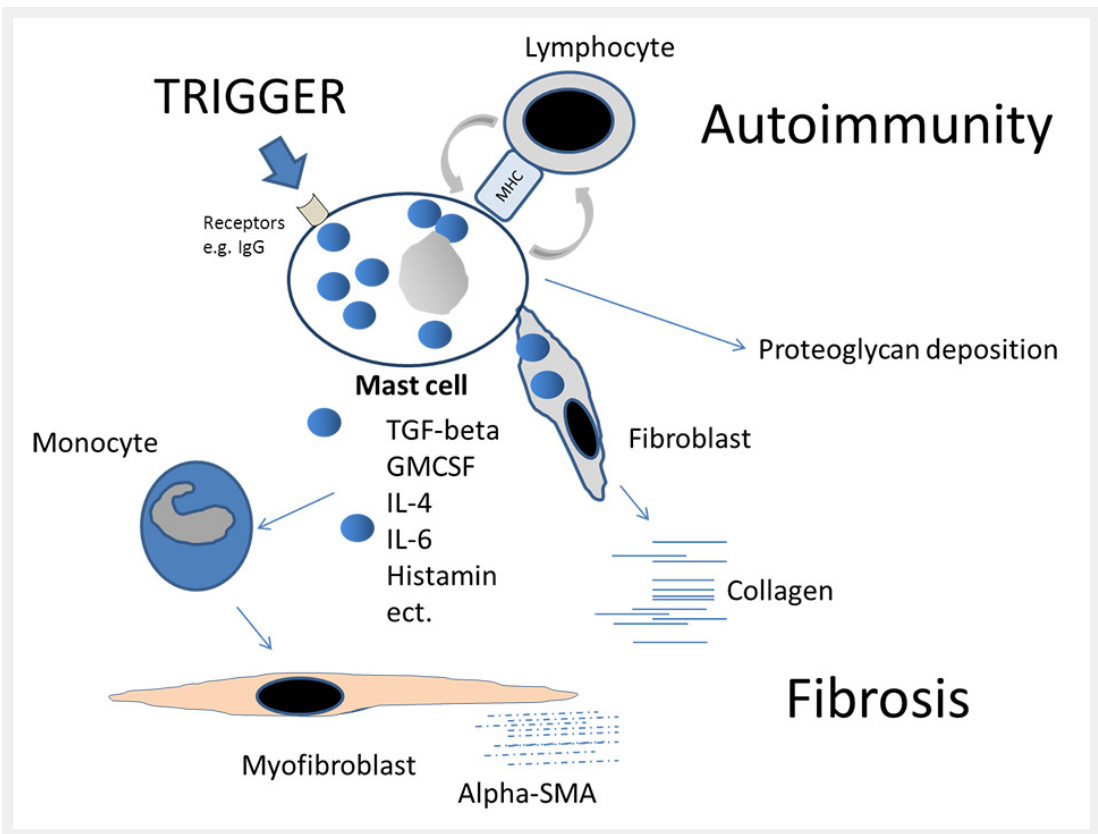
Figure 3 Schematic illustration of mast cells as key players in fibrosis. After stimulation by a trigger, e.g., IgG molecules, mast cells induce profibrotic cytokines or growth factors. Fibroblasts are stimulated and monocytes differentiate into myofibroblasts. Proteoglycans can be directly released by the mast cell in the surrounding matrix. Antigen-presentation to lymphocytes might induce autoimmunity. The suppression of mast cell degranulation by T-regulatory cells under physiological conditions can be impaired in chronic